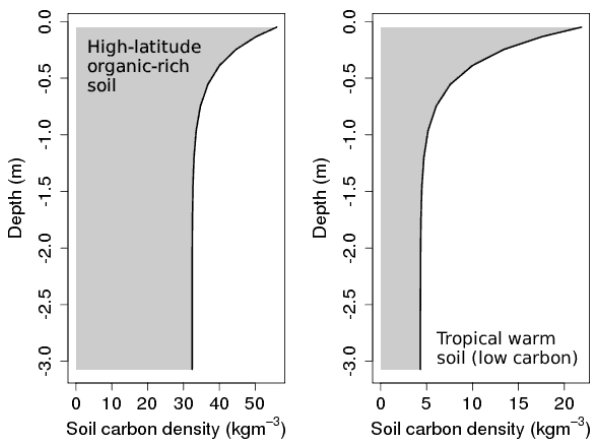
Figure 1. Soil carbon profiles generated using Eq. (1). Left: 119.75 ◦ E, 72.25 ◦ N; a grid cell with high soil carbon (Siberia). Right: − 70.25 ◦ E, 4.25 ◦ N; a warm location with most of the carbon near the surface (South